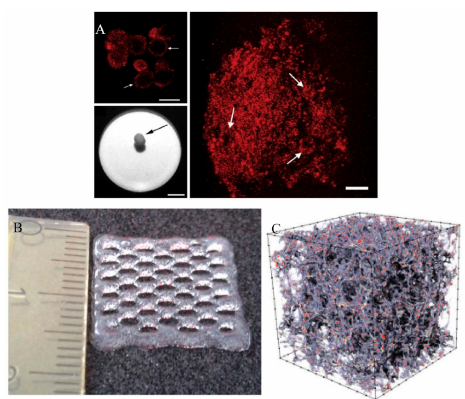
Figure 3. Illustration of exemplary ( A ) sca ff old-free, scale bar 250 µ m [118], ( B ) matrix-based (approximately 1.5 cm square) [119] and ( C ) sca ff old-based (CT image with 3 mm edge length) [120] 3D co-culture